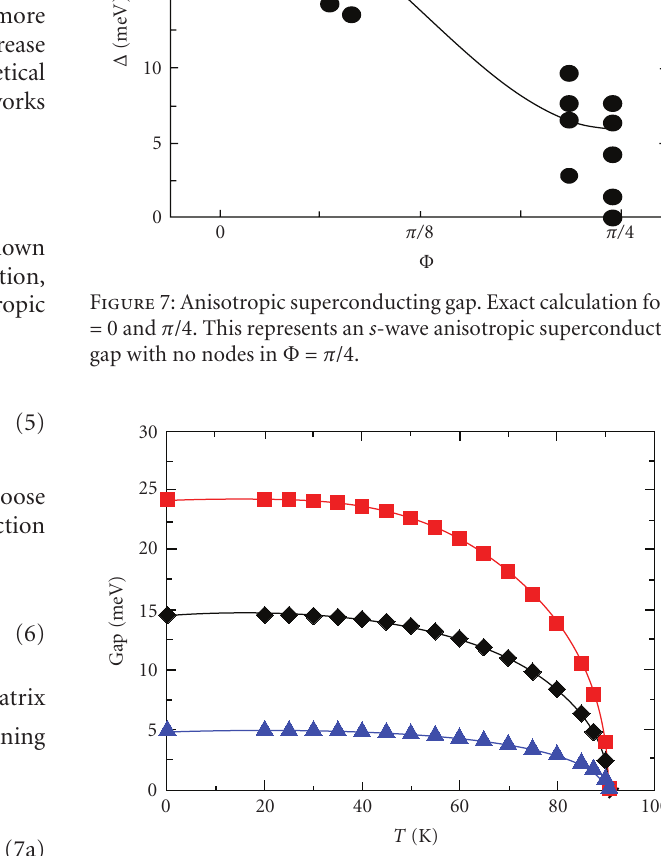
Figure 8: Variation of the various gaps Δ max , Δ min , and Δ av versus temperature, at the optimum doping, with the following parameters, t = 0.2eV, (cid:2) ω o = 60meV, q 0 a = 0.12, λ e ff = 0.665, red square symbol = Δ max , black diamond symbol = Δ av , blue up triangle symbol = Δ min